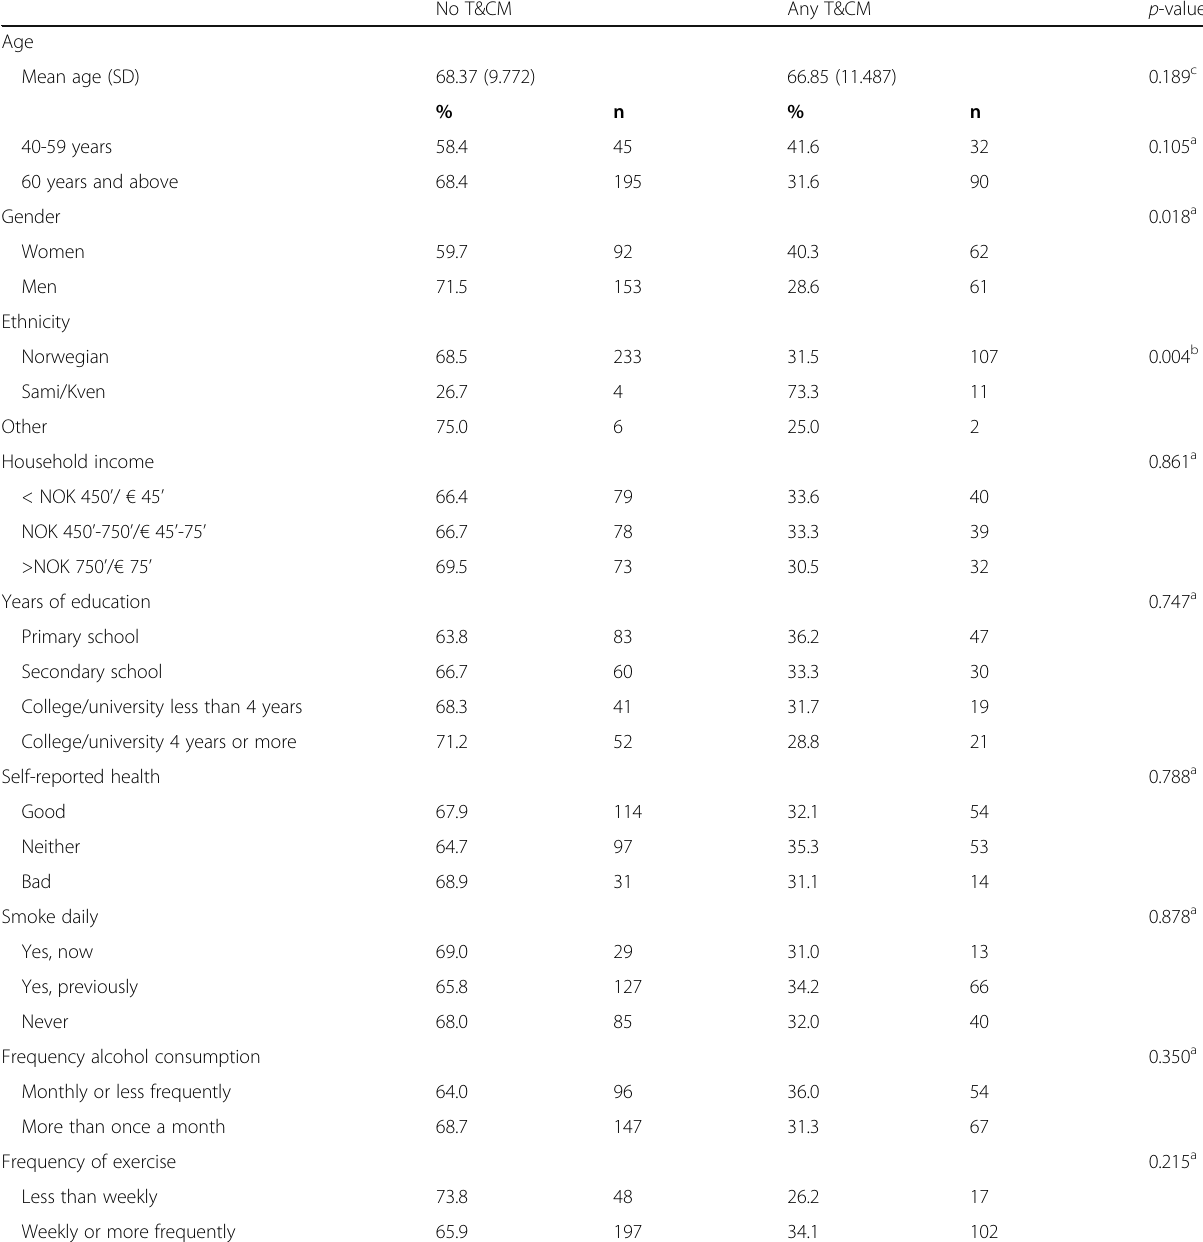
Table 3 Associations for T&CM use among participants with cancer at present No T&CM Any T&CM p